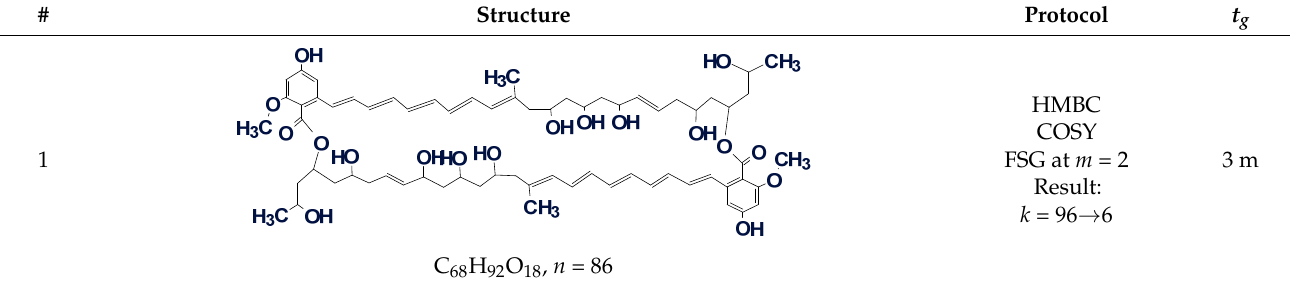
Table 1. Examples of symmetric molecules elucidated by ACD/SE. Here n is the total number of skeletal atoms and m is the number of NSCs.